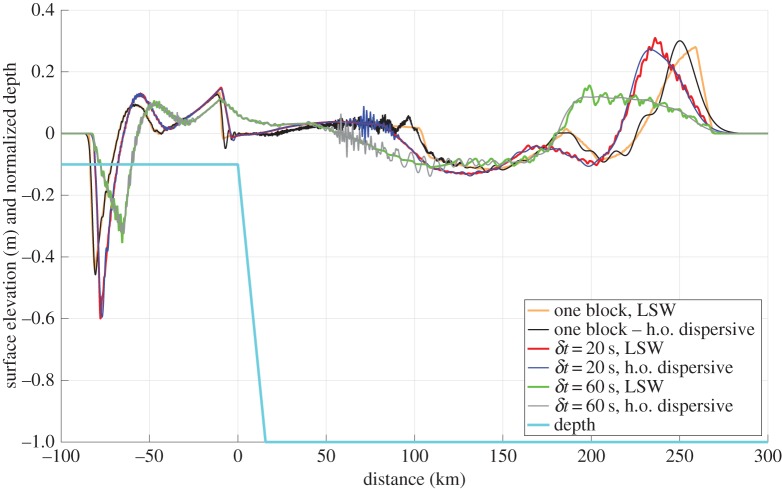
Plane wave tsunami generation by a retrogressive landslide moving downslope. Landslide kinematics is given by equation (3.4), with tb= 512 s and maximum horizontal speed um=30.6 m s−1. Three cases are considered, a single block (zero time lag), a time lag of δt= 20 s, and a time lag of δt=60 s. The depth is scaled by the maximum water depth of .